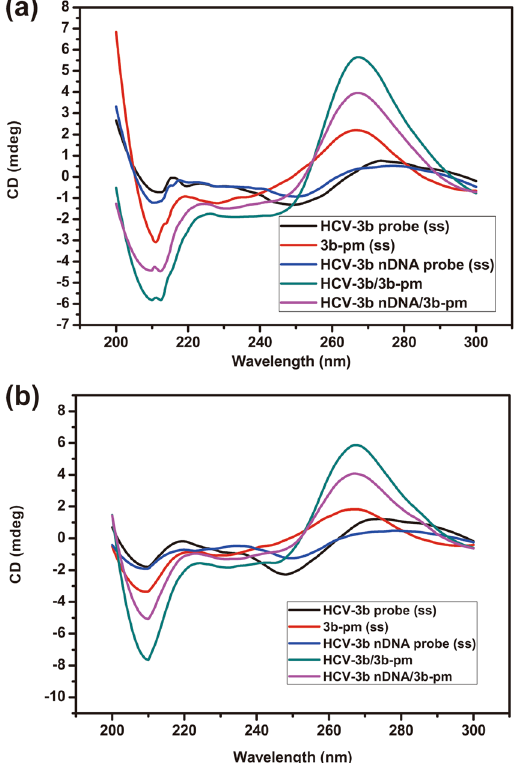
Figure 2. CD spectra of single-stranded probes, the perfect match target (3b-pm), and duplexes in BTP buffers with the concentrations of 100 ( a ) and 10 mM ( b ). The wavelength of the polarized light ranges from 200 nm to 300 nm, and the samples were prepared at 5 μ M.